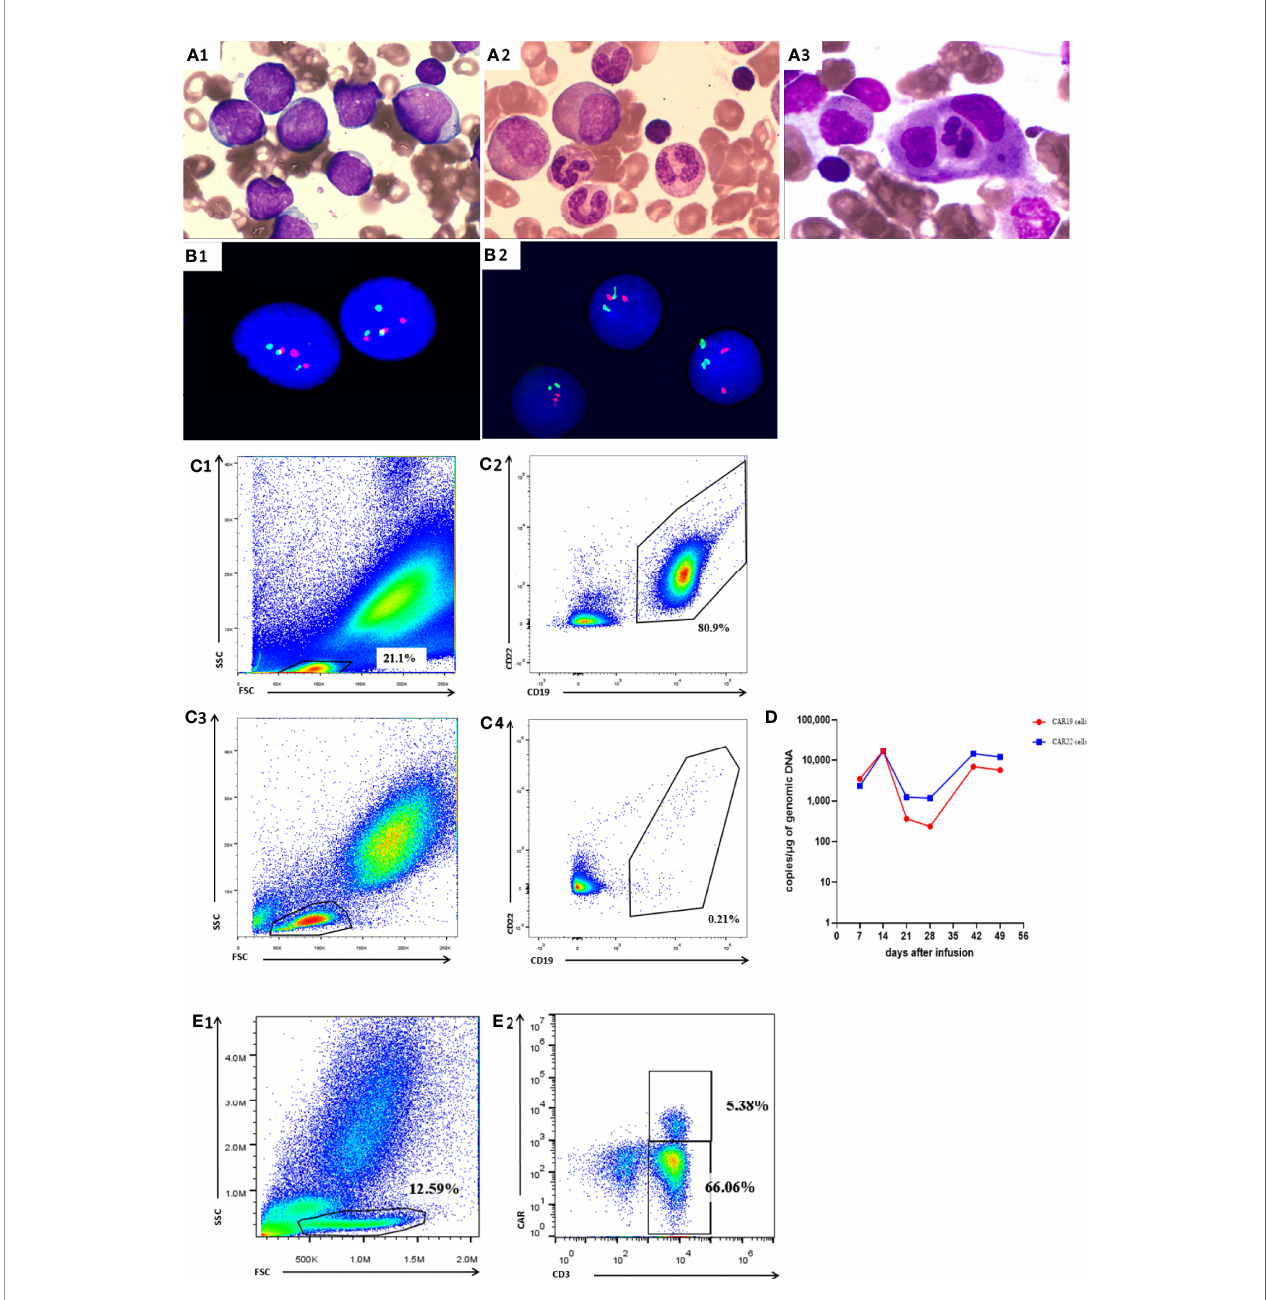
FIGURE 1 | Manifestations in Case 1. (A1) BM smear before CART therapy showed that immature lymphocytes accounted for 92.1% total cells. (A2) BM smear on day 30 showed that immature lymphocytes accounted for 4.5% total cells. (A3) BM smear on day 41 showed that less than 0.5% immature lymphocytes and about 16% hemophagocytic cells in NEC. (B1) FISH before CART therapy revealed 81% BCR/ABL gene fusion. FISH on day 30 (B2) , (B2) FISH on day 30 after CART therapy revealed undetectable BCR/ABL gene fusion after CART therapy revealed undetectable BCR/ABL gene fusion. (C1, C2) BM FCM